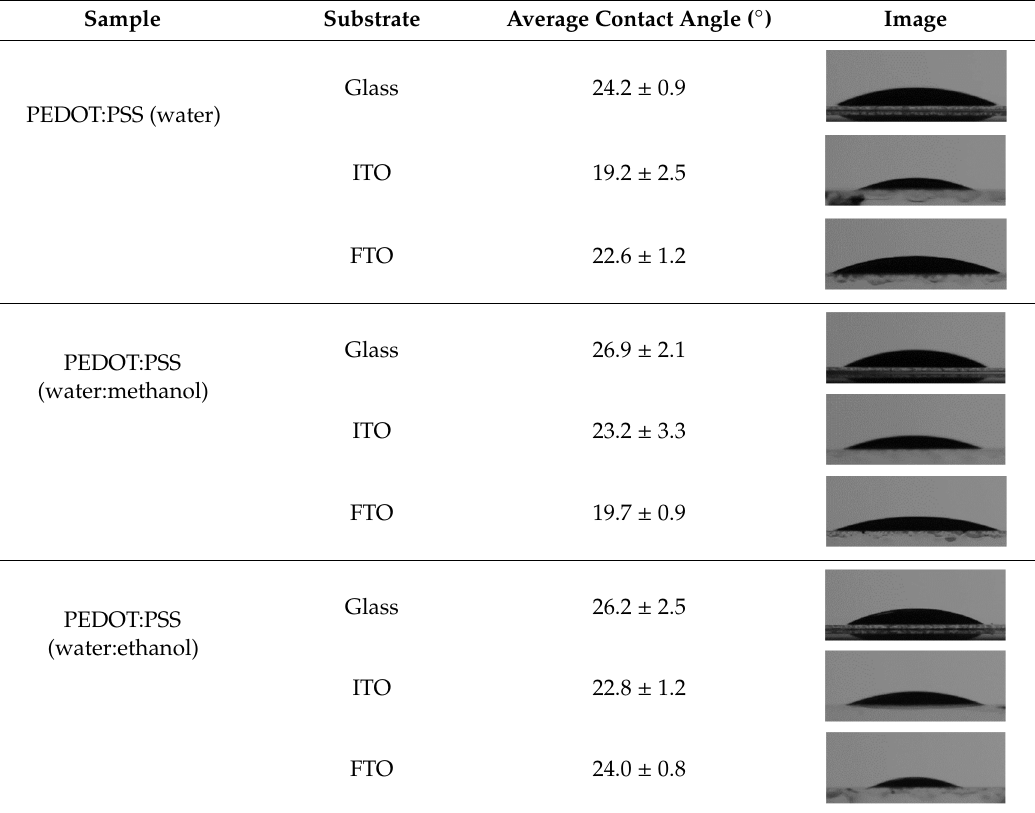
water:methanol ≤ water < water:ethanol < water:isopropanol, giving values of 19.7°, 22.6°, 24.0°, and